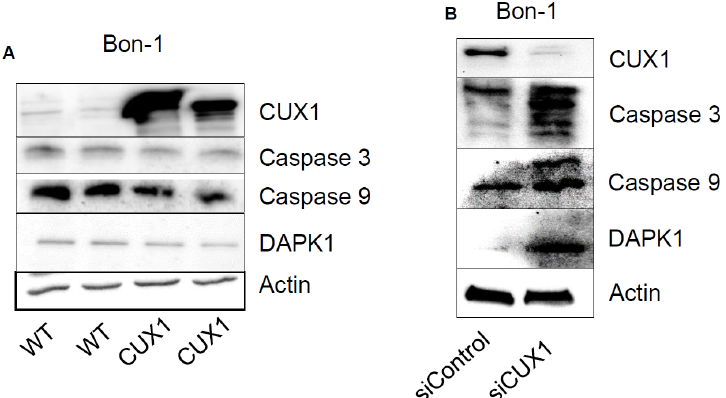
Figure 3. Regulation of caspase 3 and 9 and DAPK1 protein levels by Western blot analysis in Bon-1 cells ( A ). Two wildtype (WT) and two CUX1 overexpression clones were used. ( B ) CUX1 knock-down via siRNA in comparison to siControl in Bon-1 cells. Actin served as internal control.